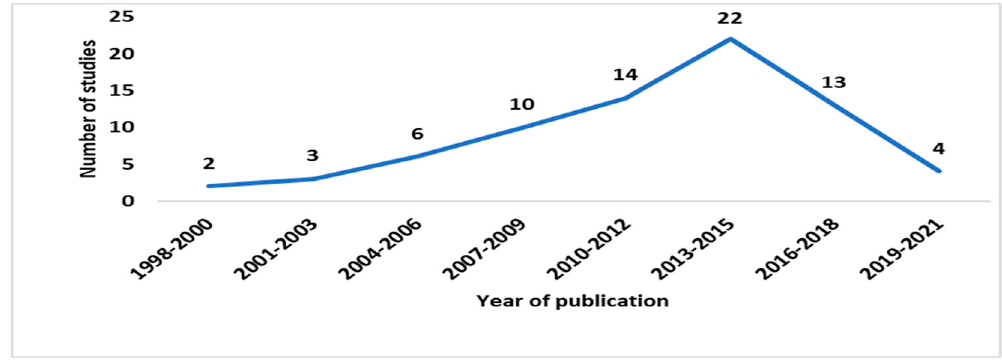
Figure 2. Frequency of studies related to LCA of agricultural production from 1998 to 2021 ( n = 74).